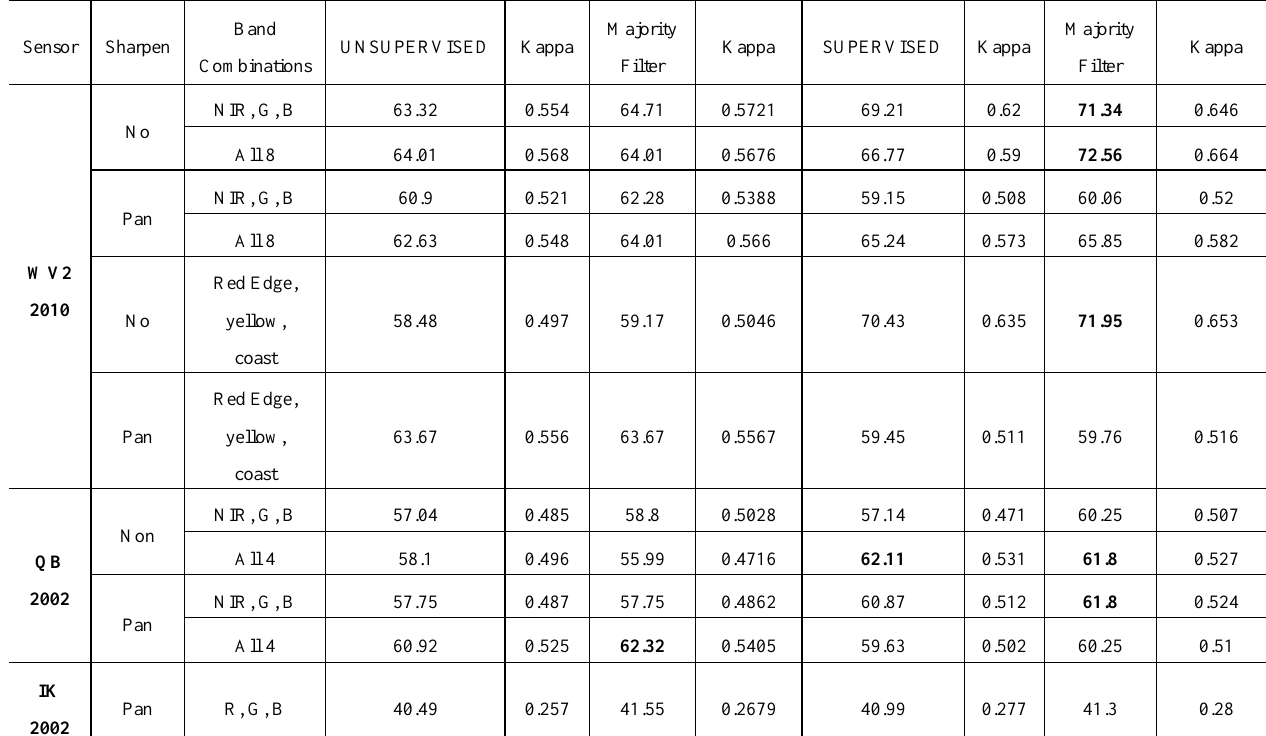
Table 3. Accuracy assessment (in percent correct) and Kappa coefficients for unsupervised and supervised classifications